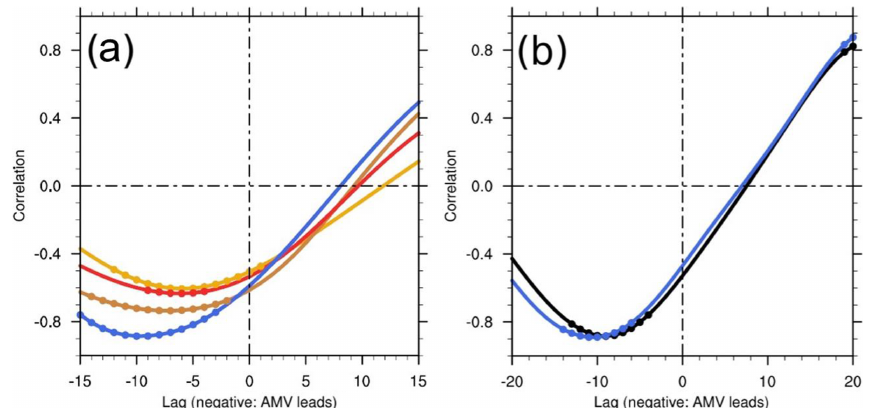
Figure 12. (a) Lagged correlations (lag in year, negative values: AMV leads) between the paleoclimate AMV index of Wang et al. (2017) and the long series of spring precipitation observed at Paris (Slonosky, 2002) over the period 1780–1889 (yellow), 1890–1989 (brown) and 1779–1989 (red). In blue, the correlations between the AMV index calculated from the 20CRv2c reanalysis and the spring precipitation from the reconstruction over the period 1882–1979. (b) Lagged correlations (lag in year) between the AMV index calculated from the 20CRv2c reanalysis and the spring river flows from (blue) the reconstruction at Paris and (black) the observations at Paris Austerlitz over the period 1882–1979. The trends in SST, precipitation and river flows series are calculated with the EEMD algorithm and subtracted from the original series before the calculation of the correlations. The series are filtered with a Lanczos filter with a 21-year window. The points represent significant correlations with a p value < 0.05 (at least 95% of the null hypothesis is rejected) according to the “phase-scrambled bootstrapping test” (Davison and Hinkley,